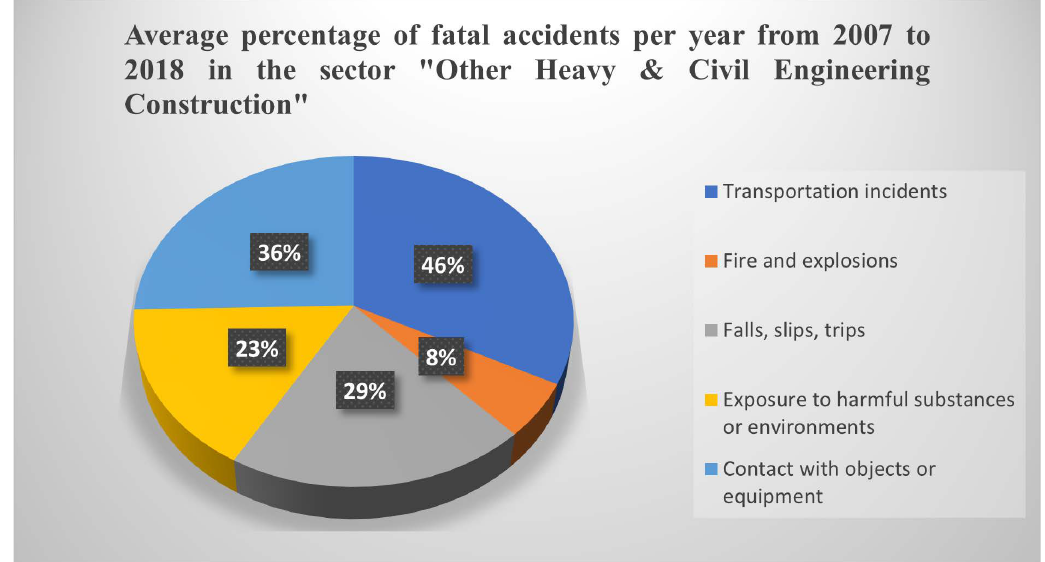
Figure 2. Annual average percentage of accidents by type of cause in the United States (calculated using data from Table 1) in the “Other Heavy and Civil Engineering Construction” sector from 2007 to